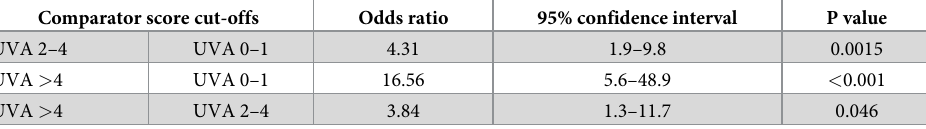
Table 3. A multivariable analysis of the differences between the UVA cut-offs in their associations with